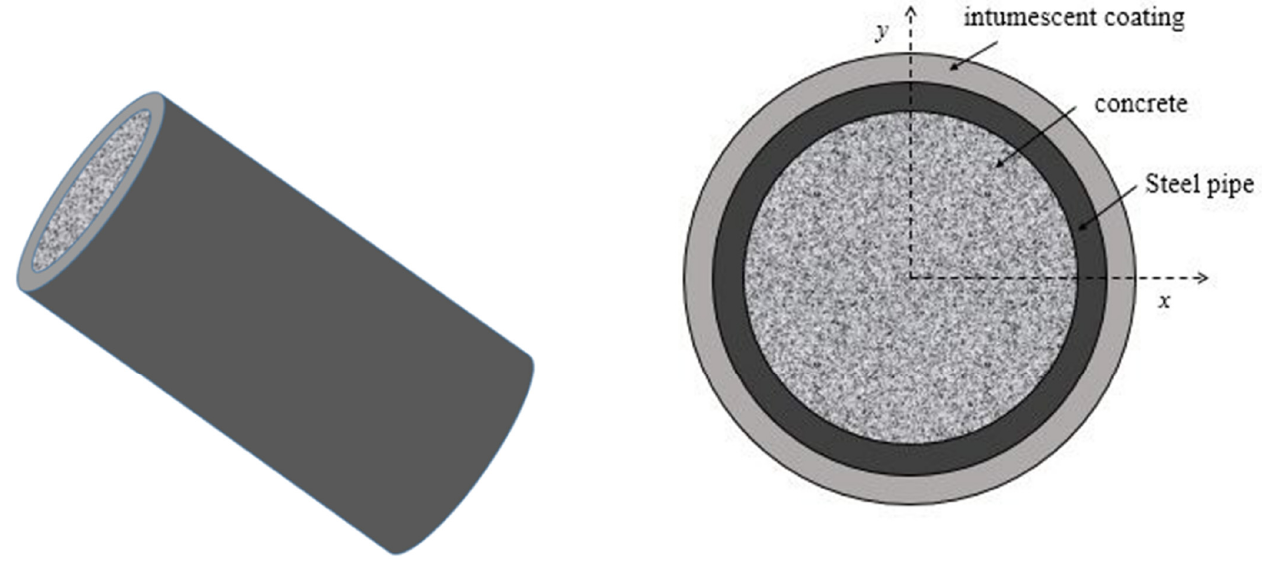
Figure 10. Physical model of the CFST structure under the protection of intumescent coating.